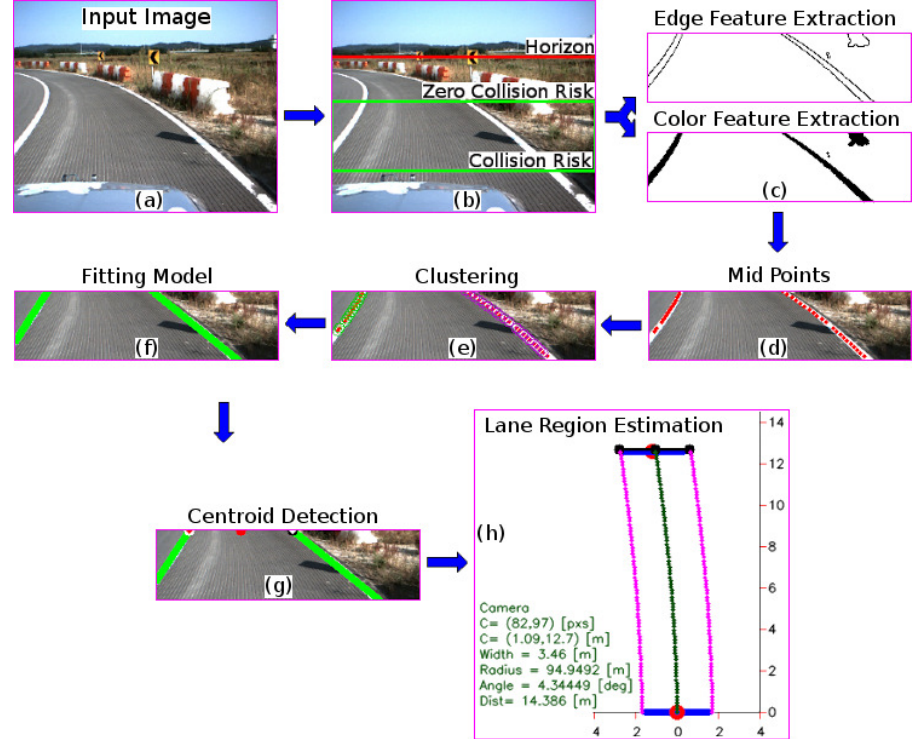
Figure 4. Flow diagram of the real-time lane region detection based on multi-features using a monocular camera from a frame. ( a ) shows the input color image; ( b ) shows the result of the region of interest extraction. The section of the image above the red line indicates the horizon region. The zero collision risk region is located between red line and the green square . The region within the green square is the collision risk region (dependent on vehicle speed), the region used in this approach; ( c ) shows the lane marking feature extraction. The top image shows the result of extracting the edge by using Otsu’s thresholding method. The bottom image shows the binary image result of extracting by using a color probability strategy; ( d ) shows the midpoints extraction method, a hybrid method which combines both the color and edge features; ( e ) shows the clustering result using a distance-based color-dependent method; ( f ) shows the fitting result. For each detected cluster, the best fitting line model is computed. Then, if the sum of the distance errors between the fitting line and the cluster is less than or equal to 15 pixels, a straight lane marking was detected; otherwise, a curve fitting model is implemented using the Lagrangian interpolation polynomial approximation; ( g ) shows the result of the centroid as well as the lane marking ending points extraction; and ( h ) shows the result of the road geometry estimation for the current frame using the centroid